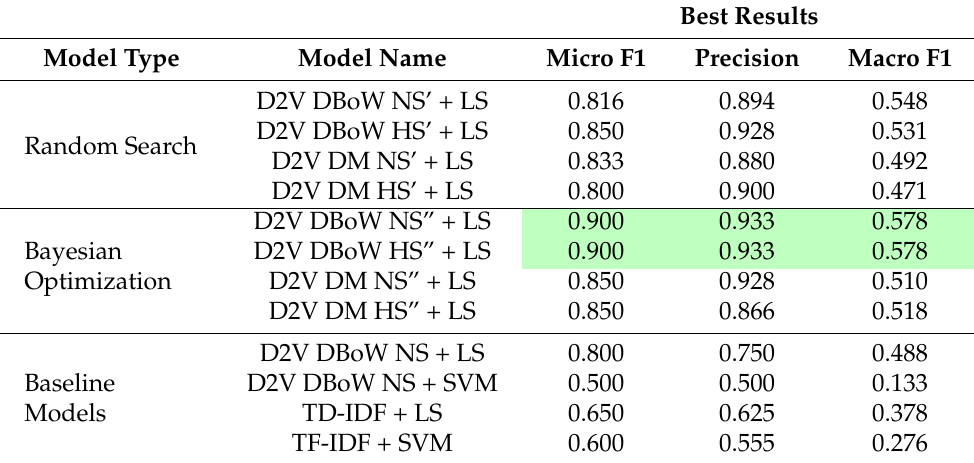
Table 6. Best predictions from the Unsafe Supervision level.